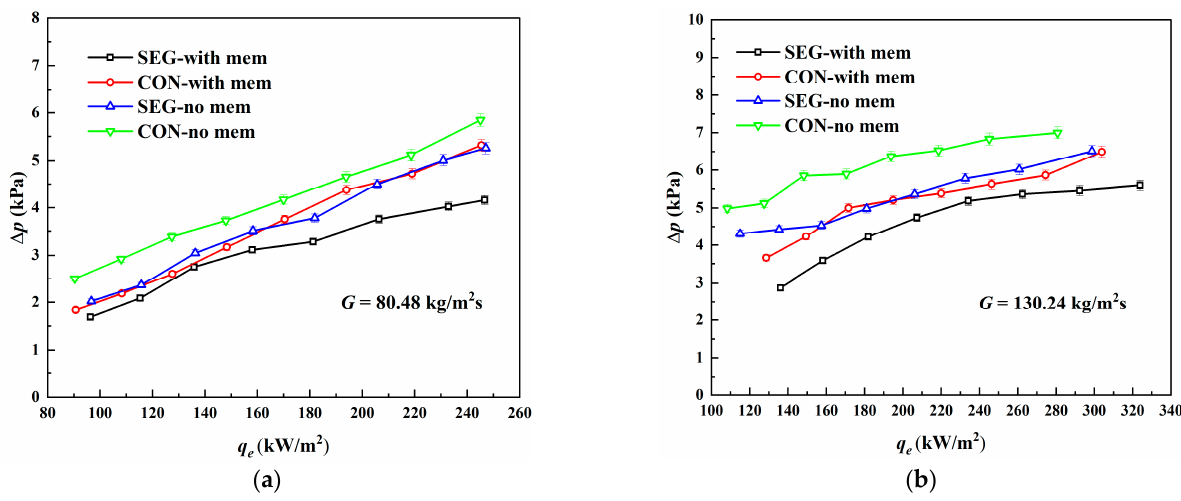
Figure 9. Pressure drops in the continuous and segmented heat sink with and without the venting membrane: ( a ) G = 80.48 kg m − 2 s − 1 ; ( b ) G = 130.24 kg m − 2 s − 1 .